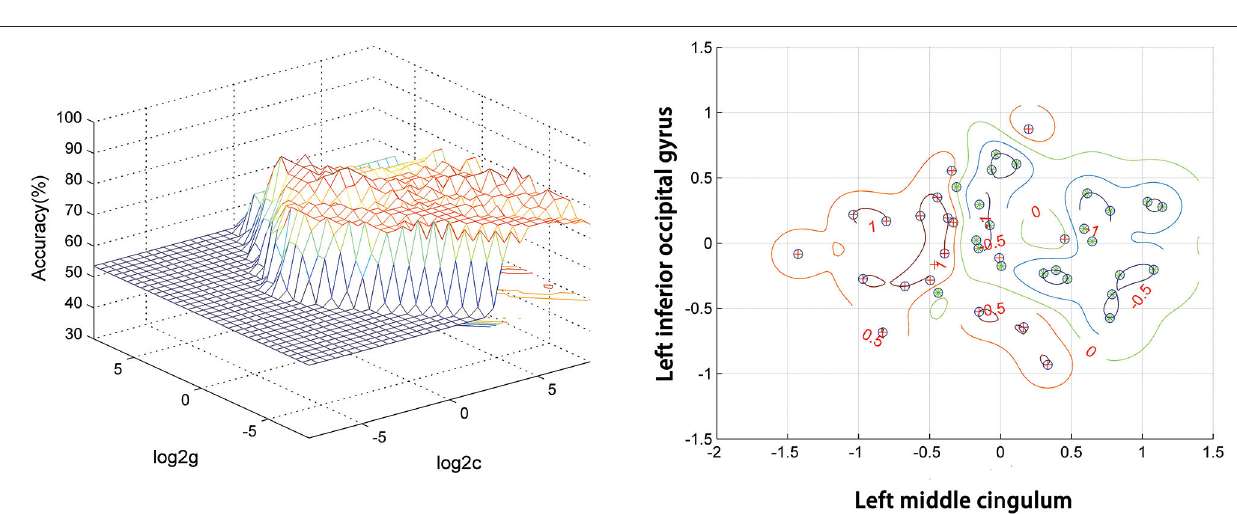
FIGURE 3 | SVM analysis of the combination of ReHo values in the left middle cingulum and the left inferior occipital gyrus. Sensitivity = 95.00%, specificity = 91.30%, and accuracy = 93.02%. SVM, support vector machines; ReHo, regional